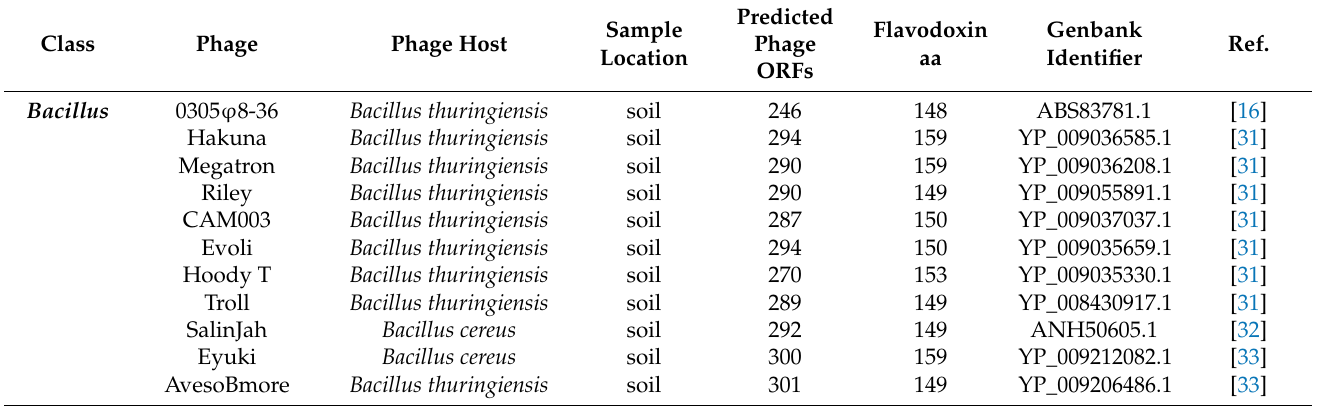
Table 1. Flavodoxin genes found in Bacillus , Listeria and Staphylococcus phage